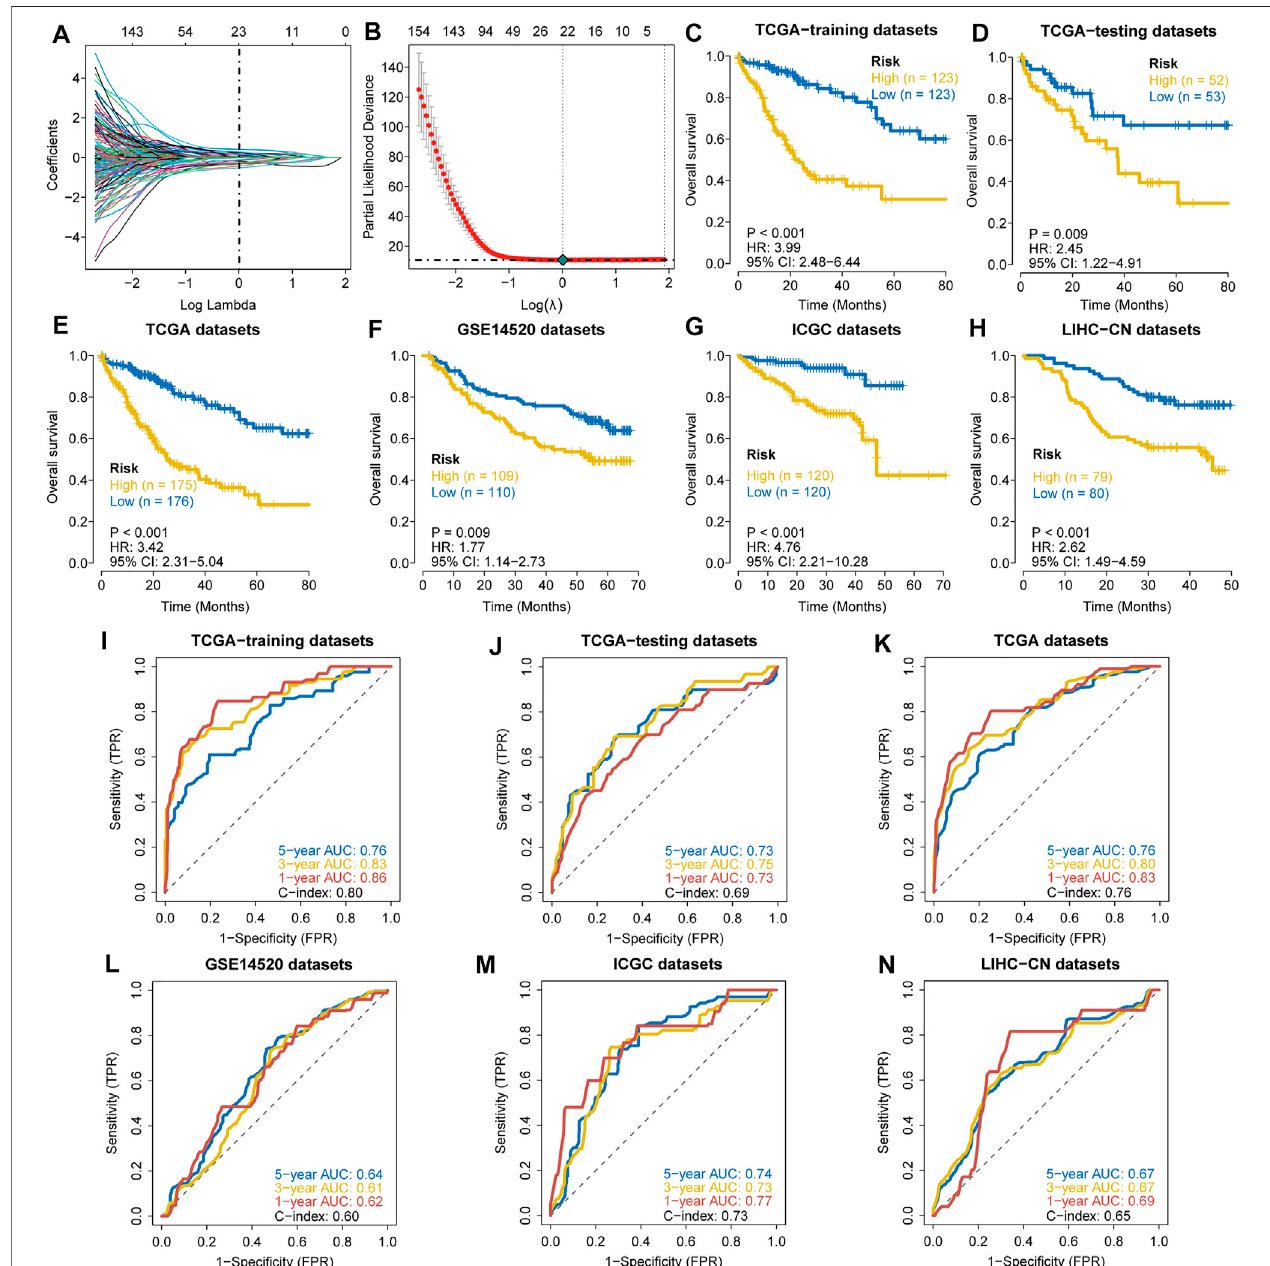
FIGURE 1 | Construction and validation of a prognostic DDR-related gene pair signature. (A,B) LASSO regression identi fi ed 23 DRGPs. (C – H) The Kaplan – Meier overallsurvival(OS)curvesintheTCGAtrainingdatasets (C) ,TCGAtesting datasets (D) ,TCGAdatasets (E) ,GSE14520datasets (F) ,ICGCdatasets (G) ,andLIHC-CN datasets (H) show that patients in the HRisk group have a poorer prognosis. (I – N) ROC curves show the predictive ef fi ciency of the signature for patients in the TCGA training datasets (I) , TCGA testing datasets (J) , TCGA datasets (K) , GSE14520 datasets (L) , ICGC datasets (M) , and LIHC-CN datasets (N) on the survival rate.